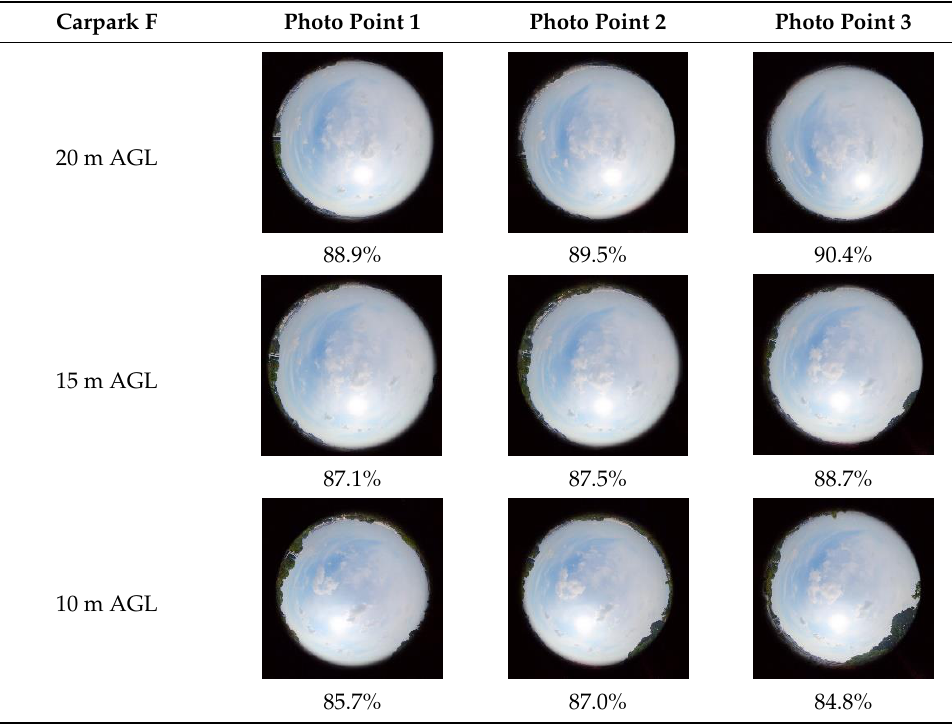
Figure 14. Graph of EPH vs. Latitudinal Value at Carpark F. Table 1. Sky Ratio at Carpark F.